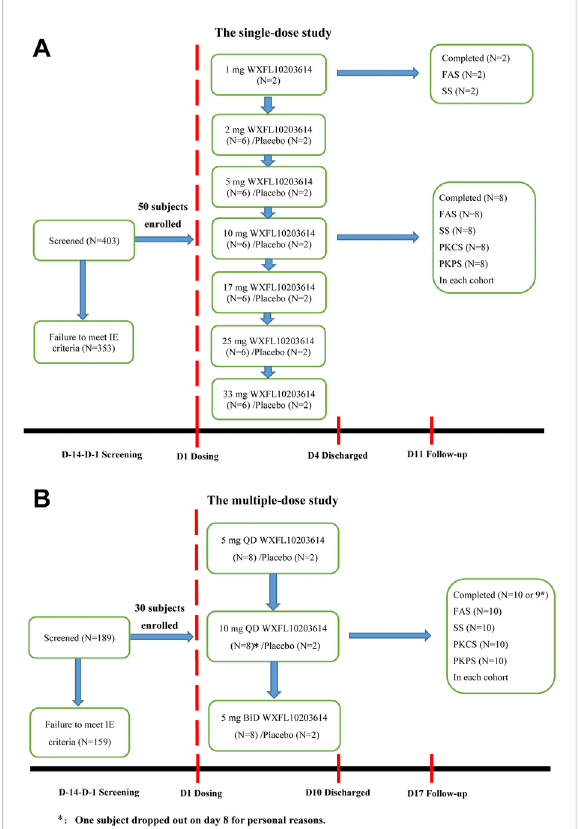
FIGURE 1 Subject disposition. (A) The single-dose study, (B) The multiple-dose study. FAS: The Full Analysis Set, SS: Safety set, PKCS:Pharmacokineticconcentrationset,PKPS:Pharmacokinetic parameter set, IE: